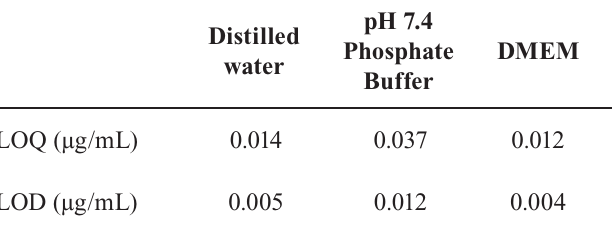
Distilled water pH 7.4 Phosphate Buffer